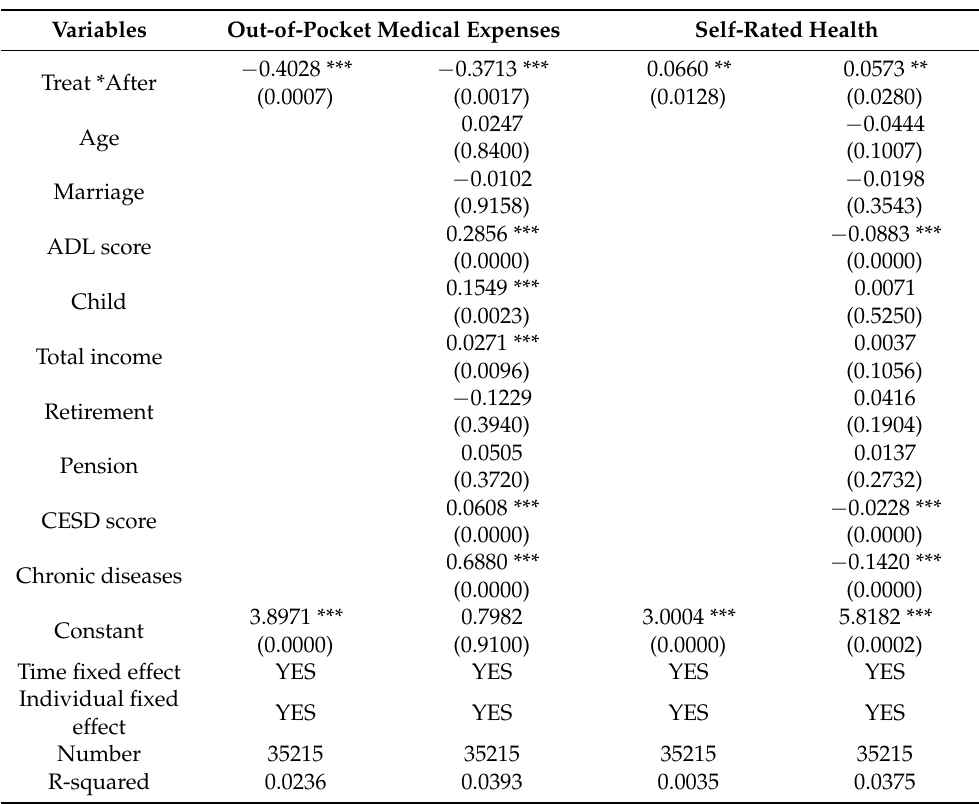
Table 6. Tail-curtailing.